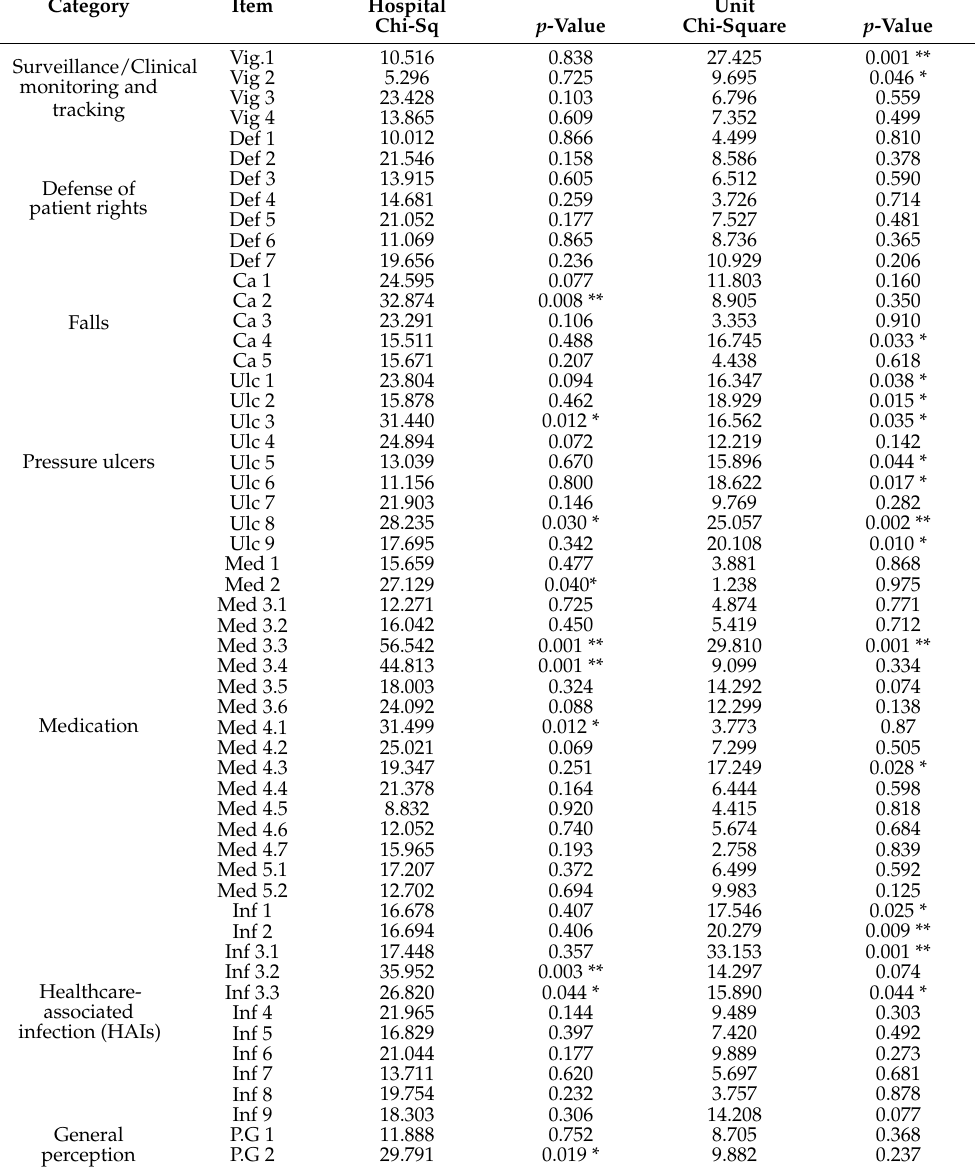
Table 3. Differences in the responses to the questionnaire according to internship hospital or